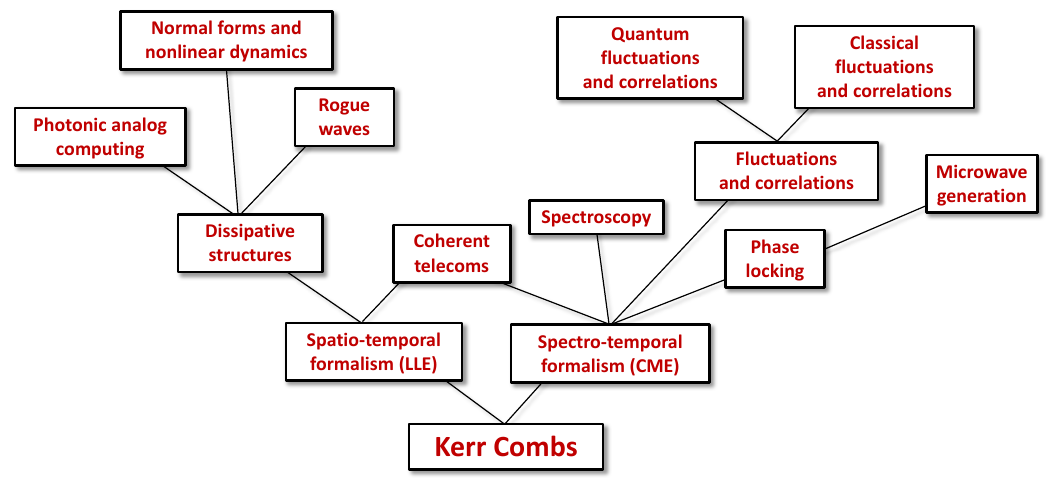
Figure 10: (Color online) Representation of some of the fundamental and applied developments related to Kerr combs. This evolutionary tree permits to visualize the cross-disciplinary nature of this